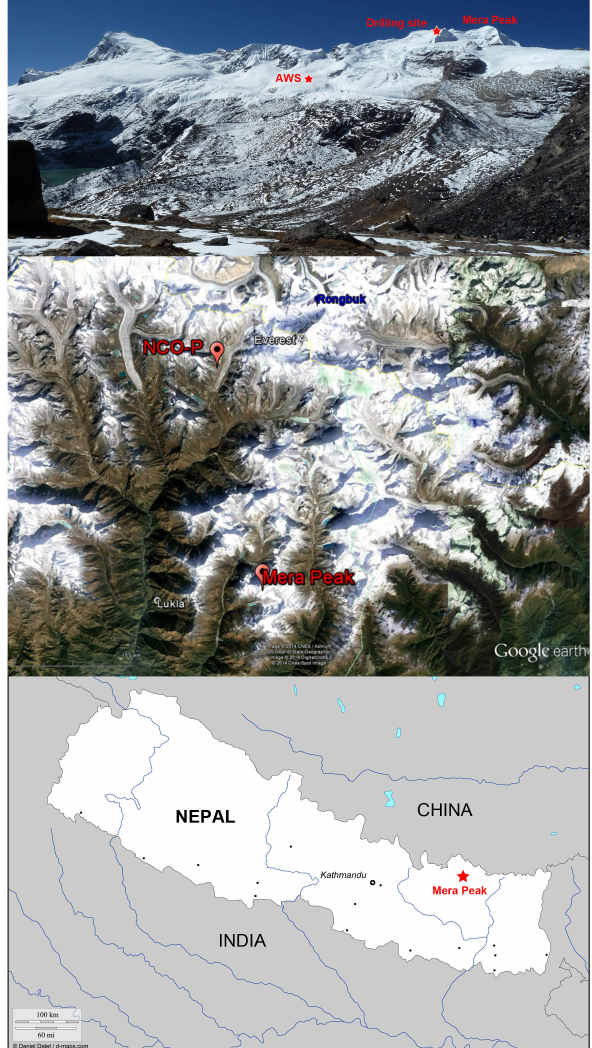
Figure 1. (a) Mera Glacier picture with the position of the drilling site and Naulek weather station, (b) Map of Nepal and border coun- tries showing the location of Mera Peak, (c) Satellite image of the high Dudh Koshi basin where the Mera Glacier and NCO-P sites are